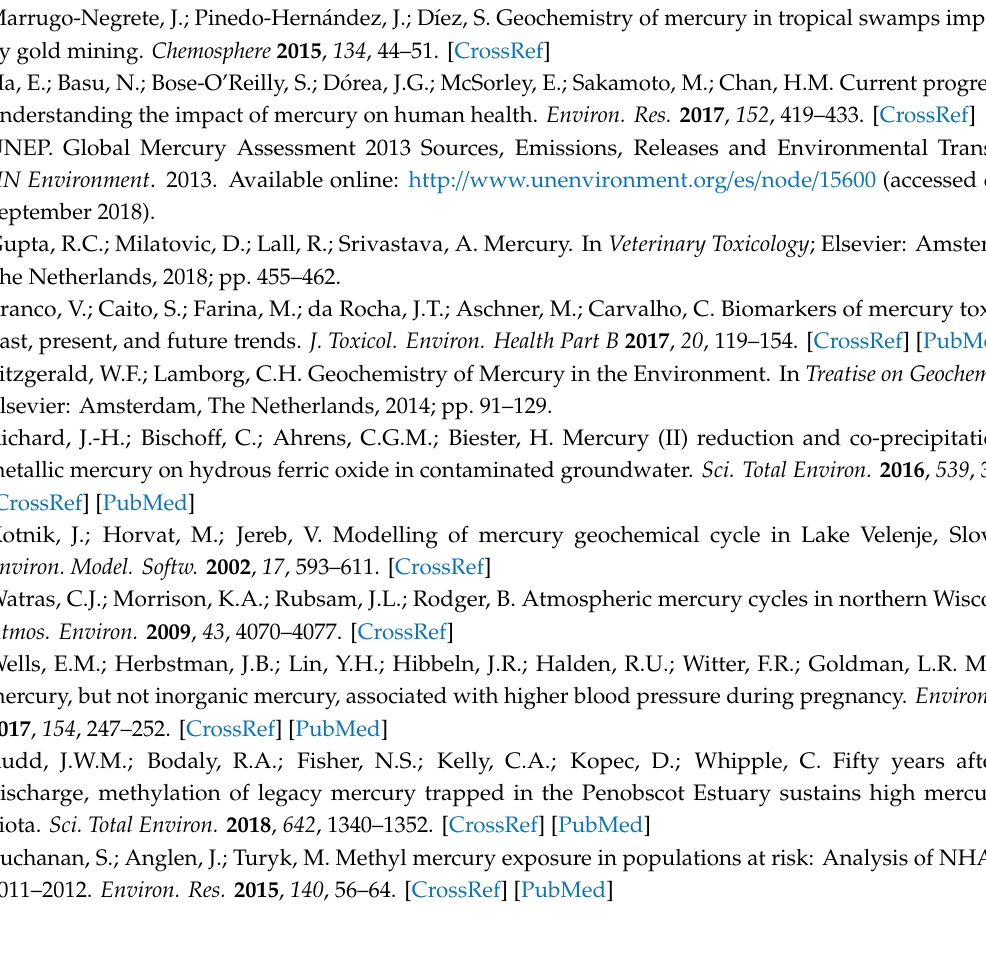
Figure S1. Diagram of BFB reactor designed for escalated treatment of Hg. V-101: Hg loading vessel. V-102: Secure vessel. P-101 and P-102: Air pumps for bubbling mixing in RH bed. R-101: Packed reactor with a filter filled with RH. Figure S2. E ffi ciency in mercury removal. (a) Single strains e ffi ciency. (b) Mixed strains e ffi ciency. D: Dead; L: Live. Figure S3. Calibration curves for dithizone. (a) Reaction in excess of mercury (0 ppm, 8 ppm and 10 ppm). (b) Reaction in excess of dithizone (0 ppm, 8 ppm). (c) Calibration curves for di ff erent proportions of Dz-Hg. Figure S4. Stability of Dz in Triton X114 at di ff erent pH. From left to right: pH 3,5,6,7,8. Figure S5. Detail of a L. sphaericus cell attached to RH surface. Figure S6. EDS-SEM of E. coli K12 C600 after 1 h in contact with HgCl 2 . Figure S7. RH with a large Hg particle attached to its